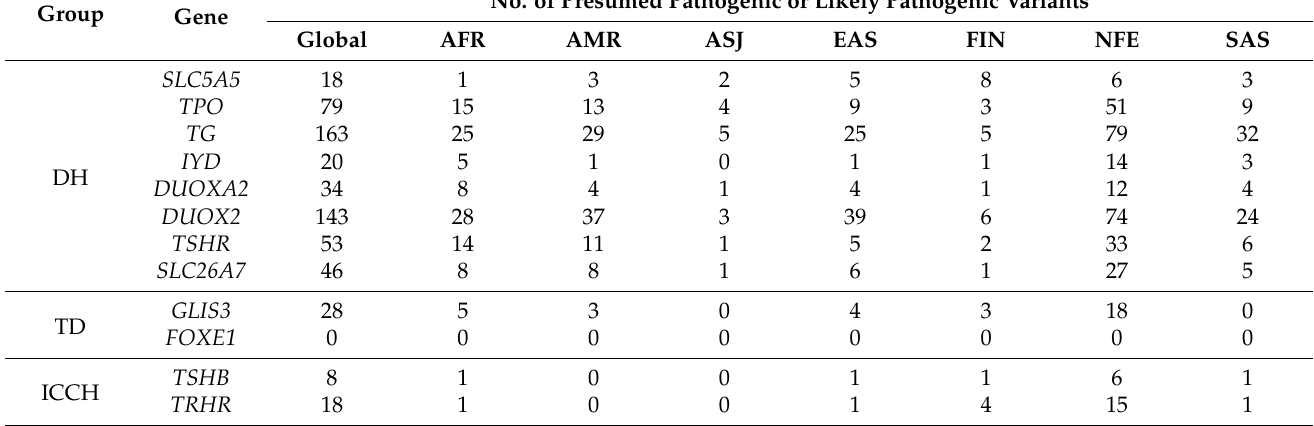
DH, thyroid dyshormonogenesis; TD, thyroid dysgenesis or syndromic primary congenital hypothyroidism; ICCH, isolated central congenital hypothyroidism; AFR, African/African American; AMR, Latino/Admixed American; ASJ, Ashkenazi Jewish; EAS, East Asian; FIN, Finnish; NFE, Non-Finnish European; SAS, South